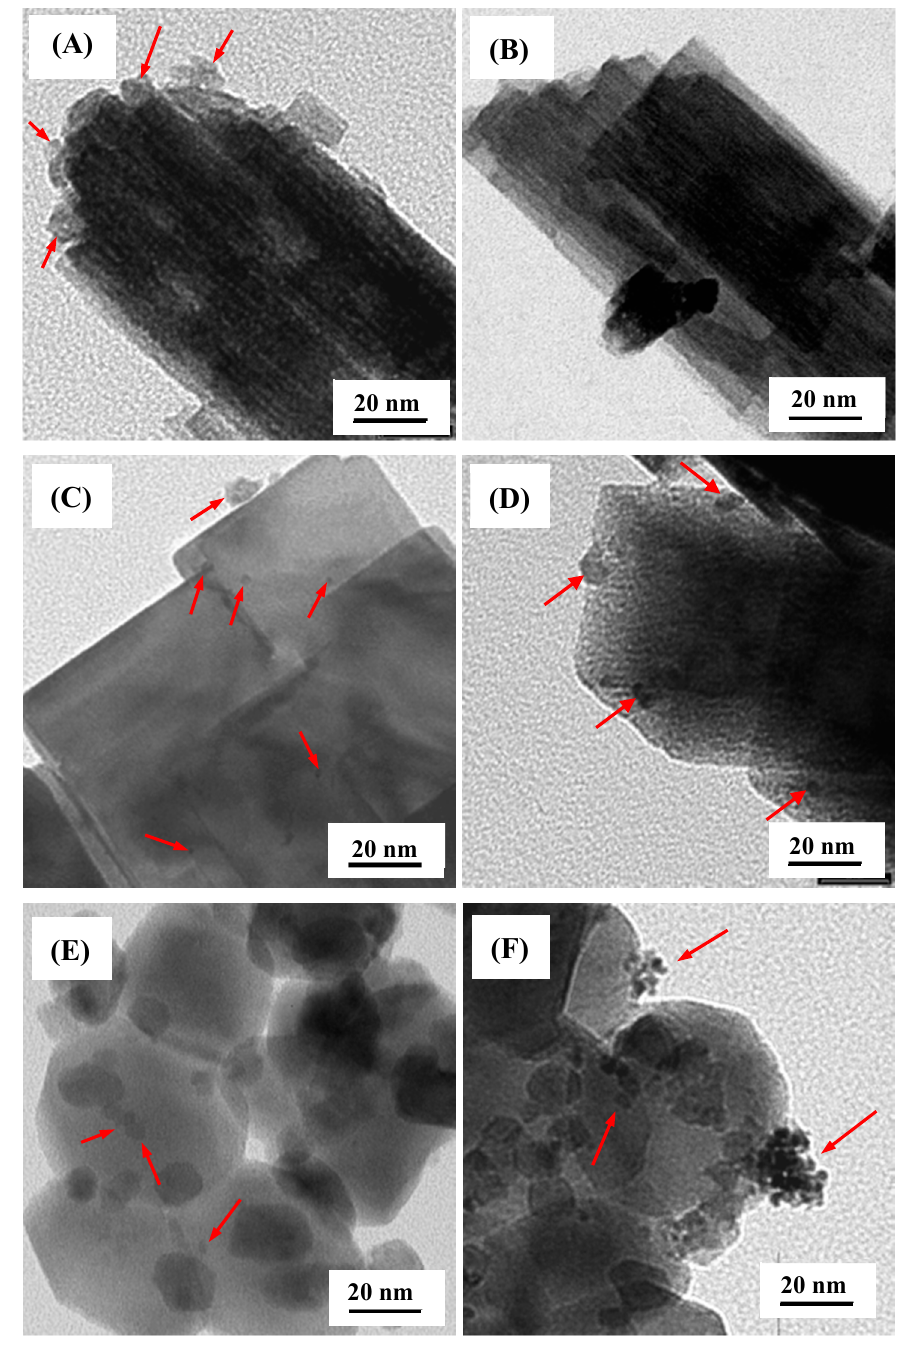
Figure 2. TEM micrographs of Pt photodeposited on WO 3 nanorod bundles W7.6NaS using ( A ) UV-A light and ( B ) visible light; WO 3 nanocubes W7.6HS using ( C ) UV-A light and ( D ) visible light; Sigma Aldrich WO 3 WSA using ( E ) UV-A light and ( F ) visible light. Arrows indicate the Pt